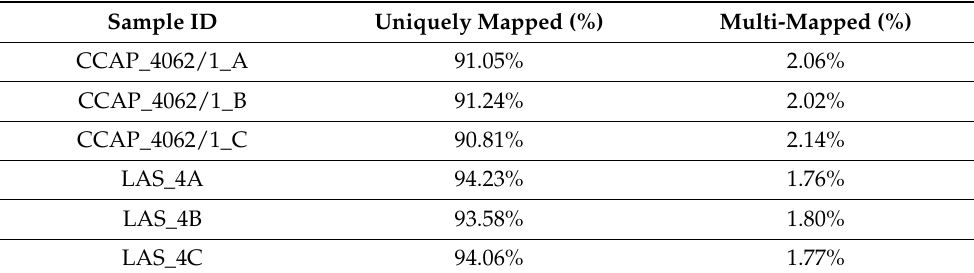
Table A4. Results of the RNA-seq data mapping against the reference genome.